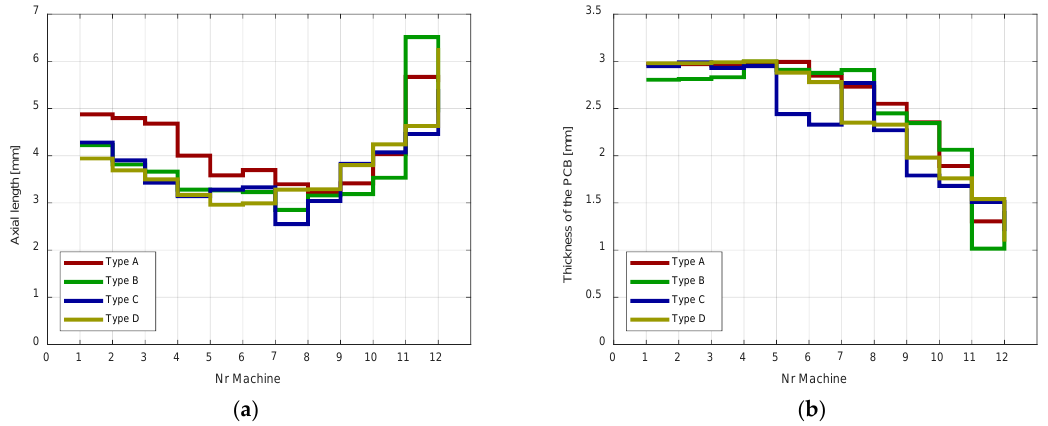
Figure 13. Axial length ( a ) and PCB thickness ( b ) of the machines belonging to the four Pareto fronts.